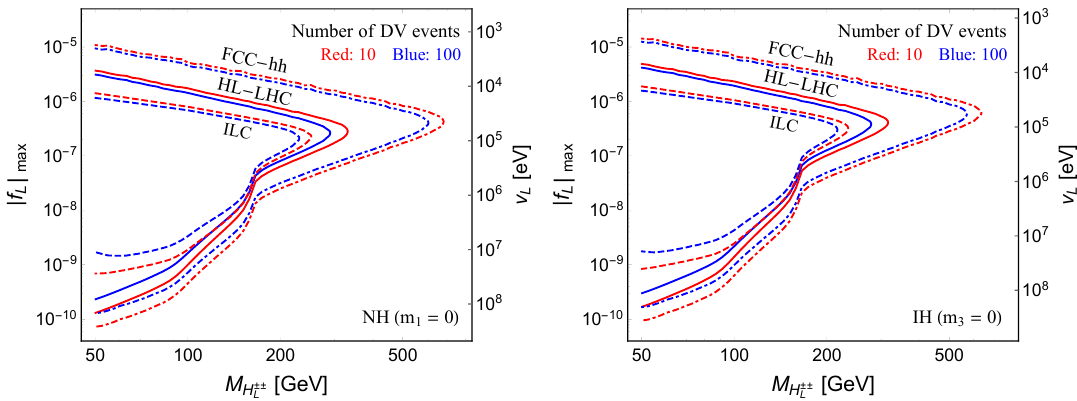
Figure 9 . Prospects of DVs from the decay H (cid:6)(cid:6) ! e (cid:6) e (cid:6) ; e (cid:6) (cid:22) (cid:6) ; (cid:22) (cid:6) (cid:22) (cid:6) in type-II seesaw, at L HL-LHC 14 TeV and an integrated luminosity of 3000 fb (cid:0) 1 (solid contours), the 100 TeV collider FCC-hh with a luminosity of 30 ab (cid:0) 1 (dot-dashed contours) and ILC 1 TeV with 1 ab (cid:0) 1 (dashed contours). The red and blue contours respectively correspond to 10 and 100 DV events, as functions of M and the largest Yukawa coupling j f L j max , for the neutrino spectra of NH (left) and IH H (cid:6)(cid:6) L (right) with lightest neutrino mass m 0 = 0. The corresponding values of the VEV v L are also shown in these